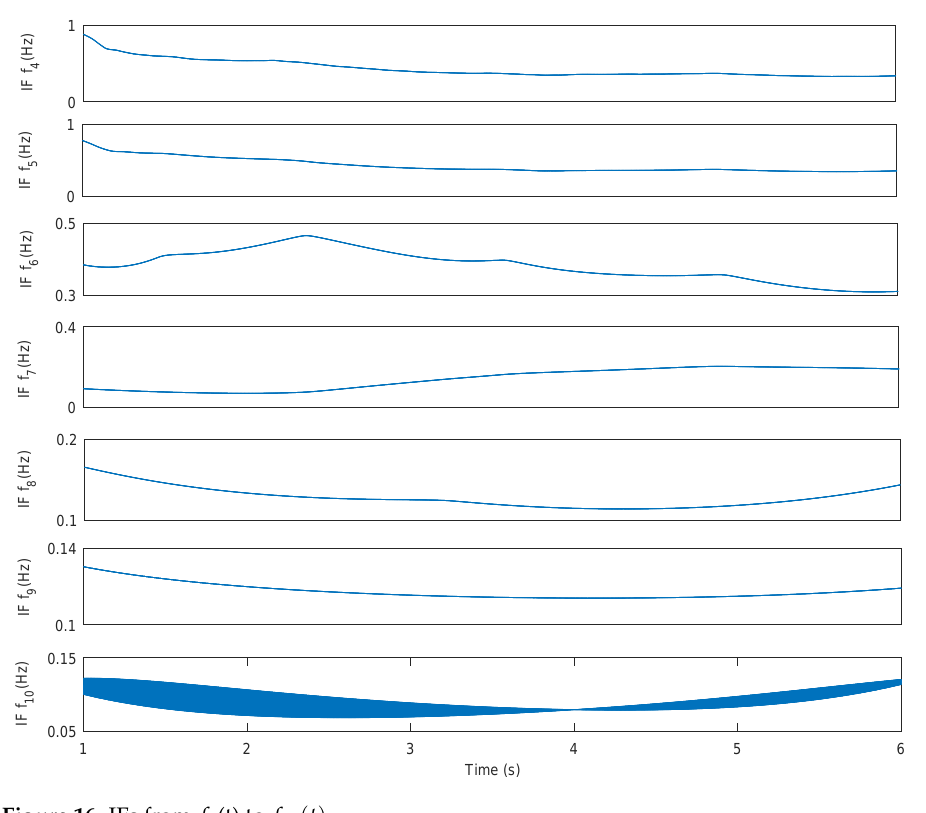
Figure 16. IFs from f 4 (t) to f 10 ( t )